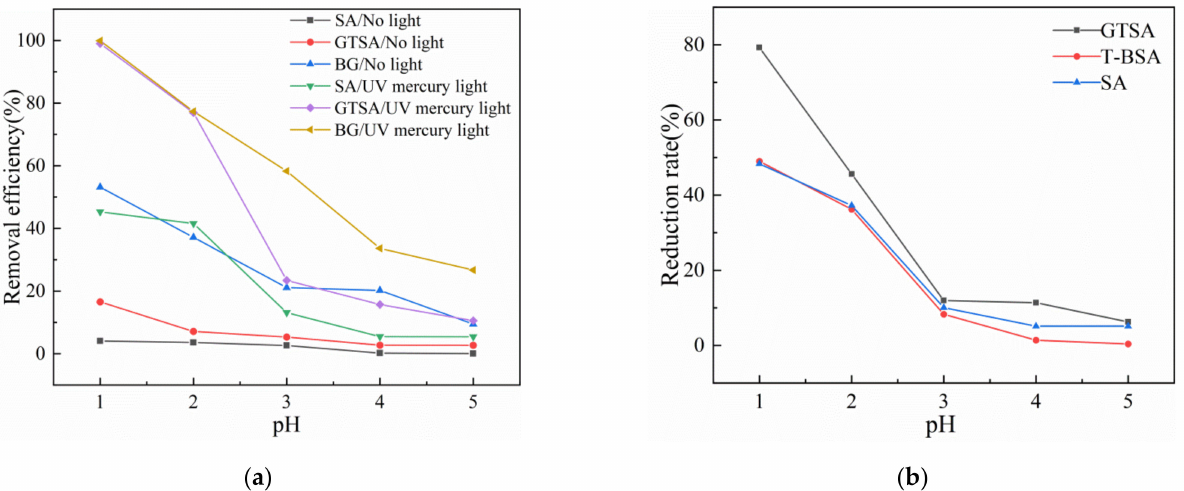
Figure 1. ( a ) Effect of light and pH values on Cr(VI) removal; ( b ) Cr(VI) reduction rate under UV light at different pH